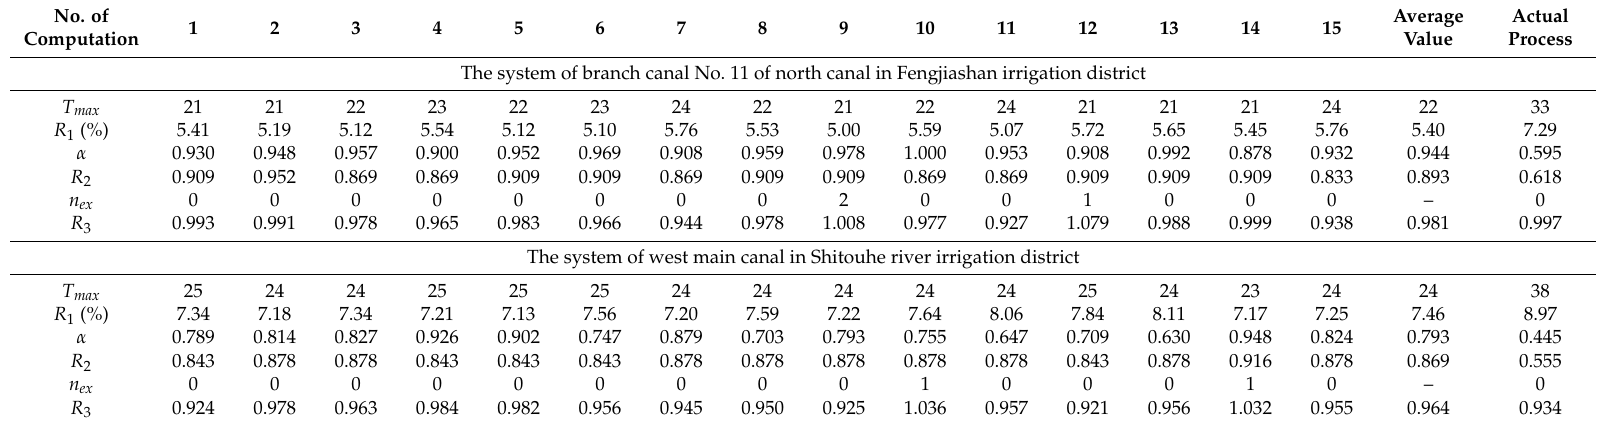
Table 2. Water delivery scheduling results of 15 repeated optimizations compared with the traditional